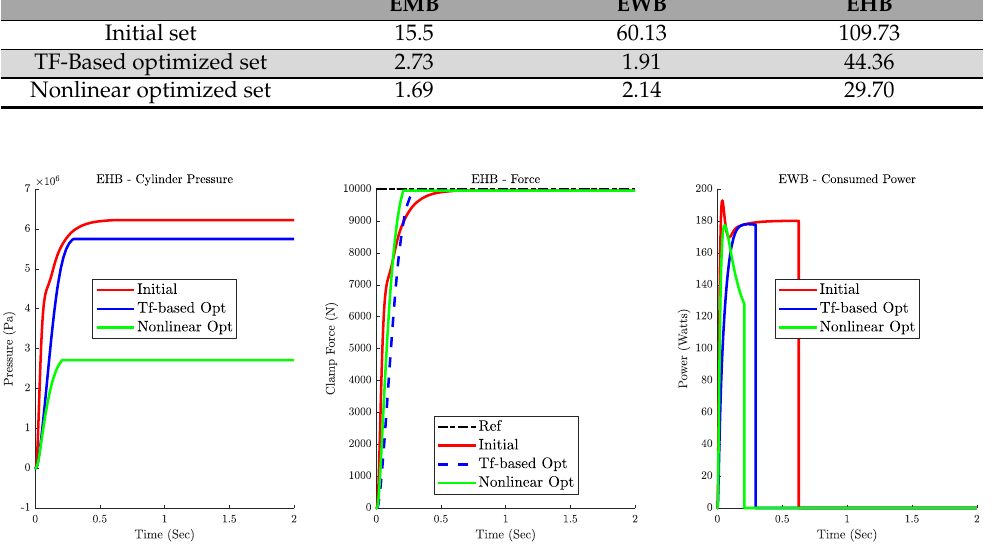
Figure 8. Comparison of the initial parameter sets vs. optimized in an EHB for a 10 kN step input. The clamp force plot for the initial parameter setting was consistent with Zhao et al. [33]. The optimized results are the novelty of this paper.